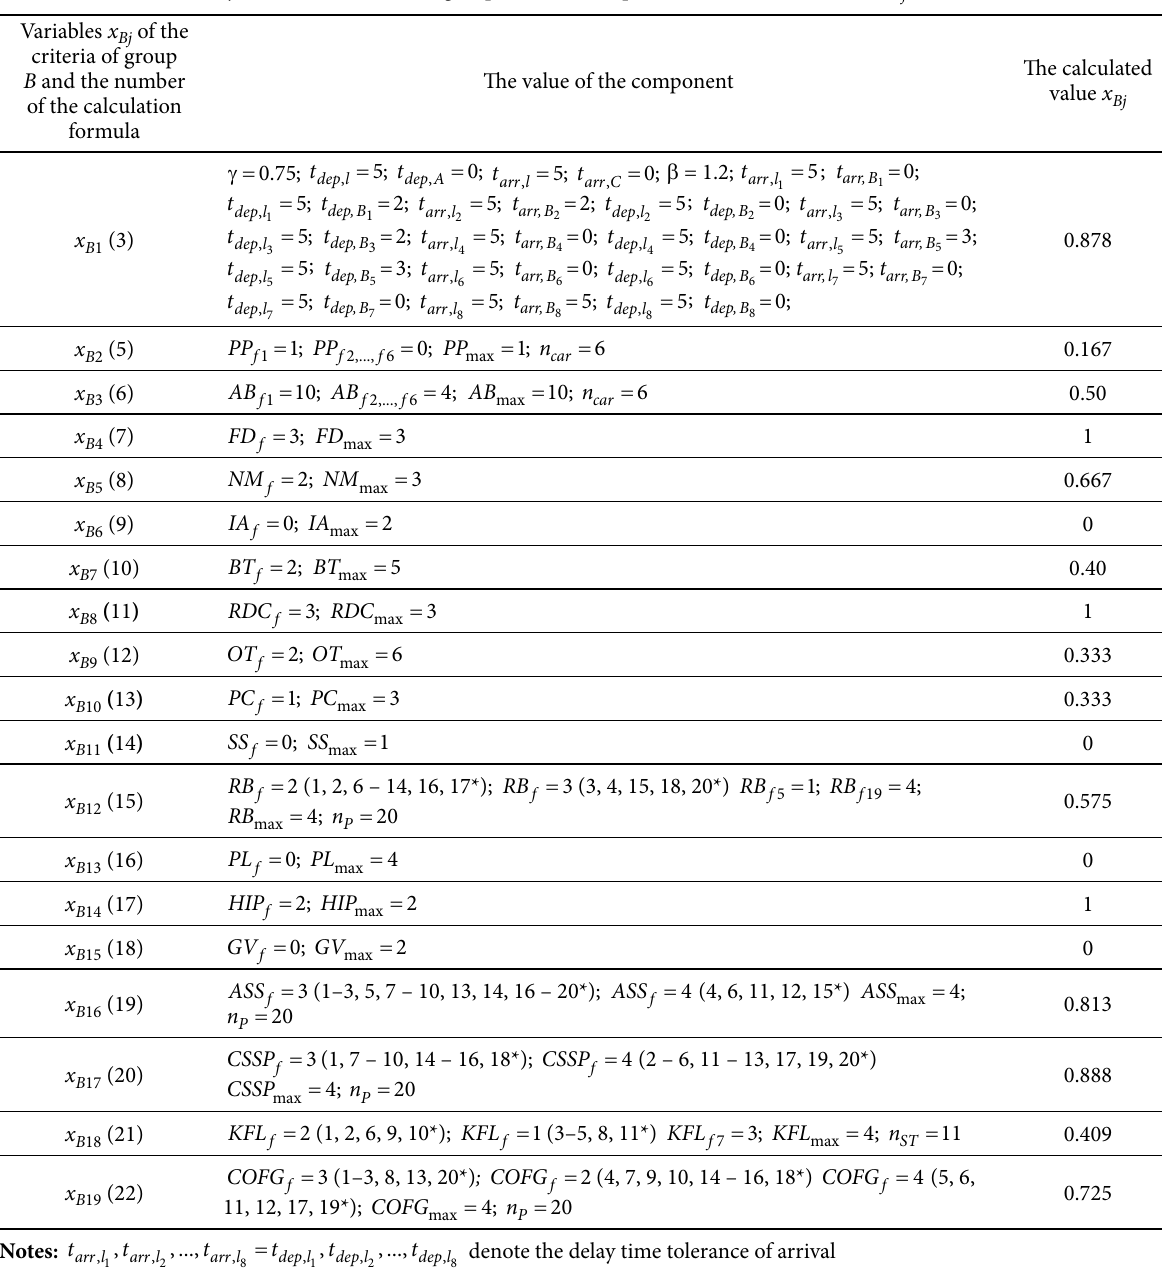
The value of the component